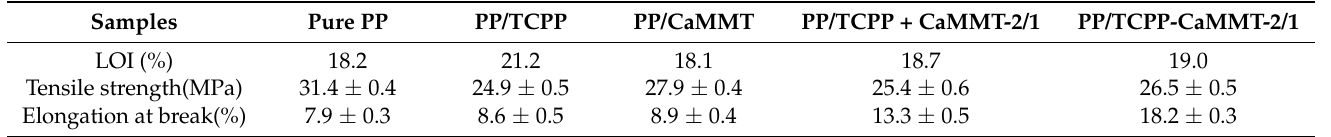
Table 5. Flame retardancy and mechanical properties of PP